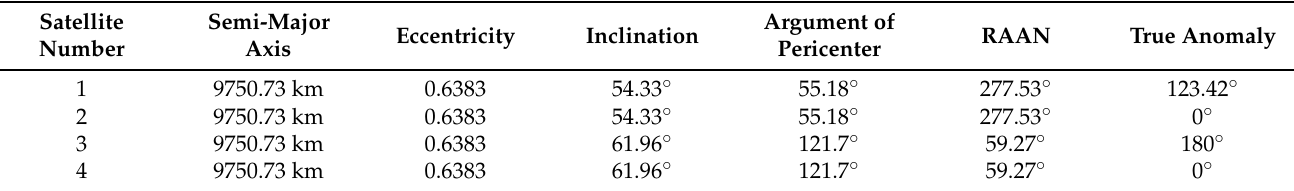
Table 1. Kepler elements of the LCNS ELFO orbits. Note that the orbits have not been optimised and are therefore not representative of the Moonlight orbits. RAAN refers to the right ascension of the ascending